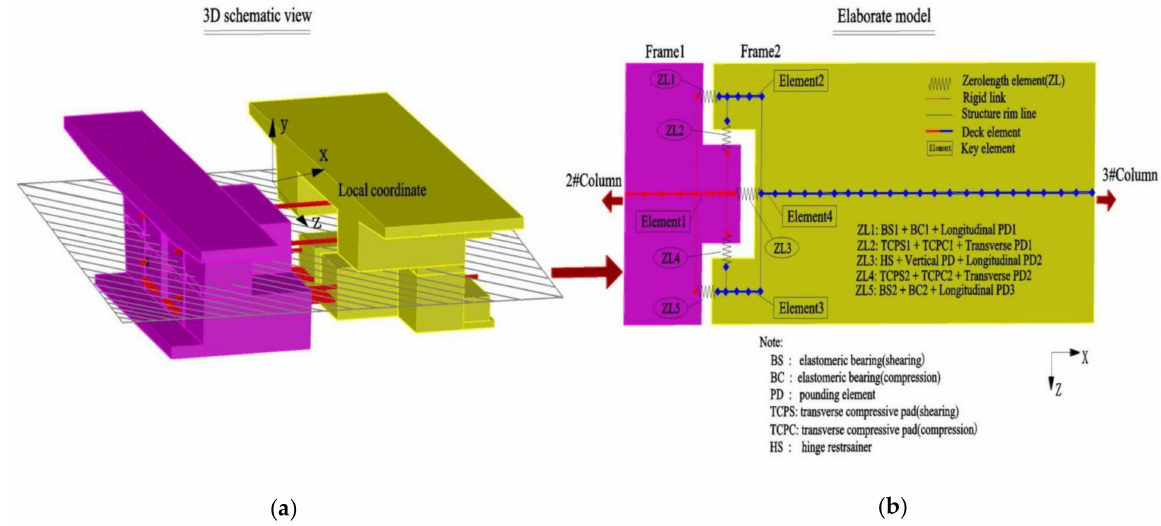
Figure 1. Plug-type hinge: ( a ) 3D schematic view and ( b ) numerical